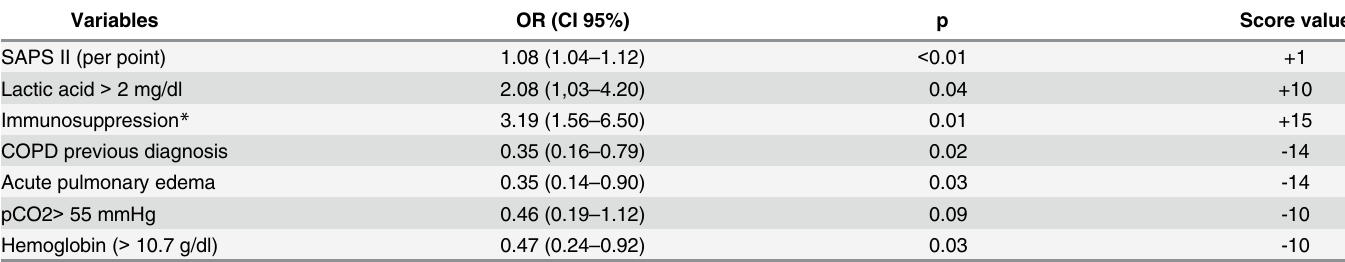
Table 5. Logistic regression and score customization for SAPS II.